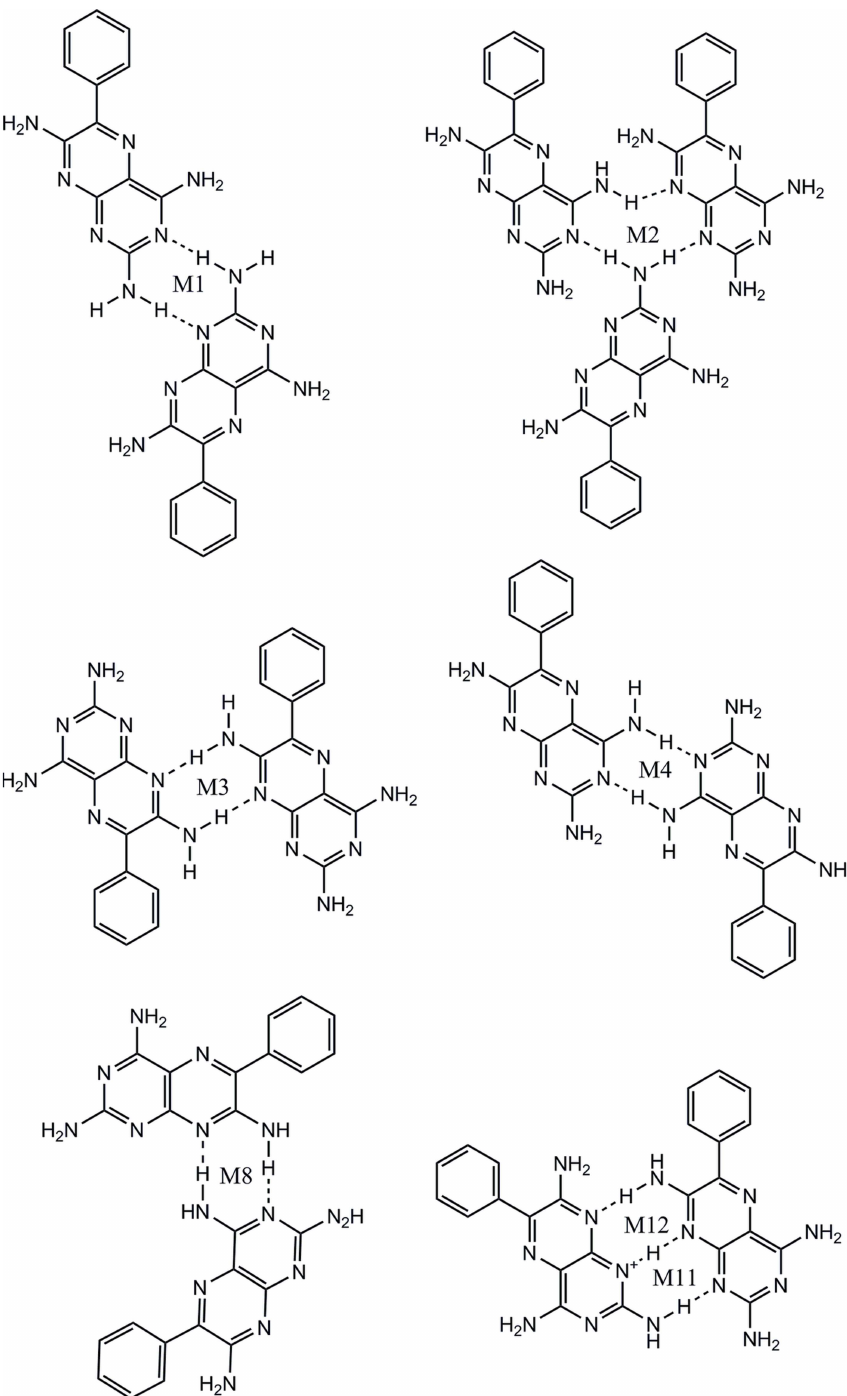
Figure 17 Hydrogen-bonded motifs between molecules of 1 observed in this